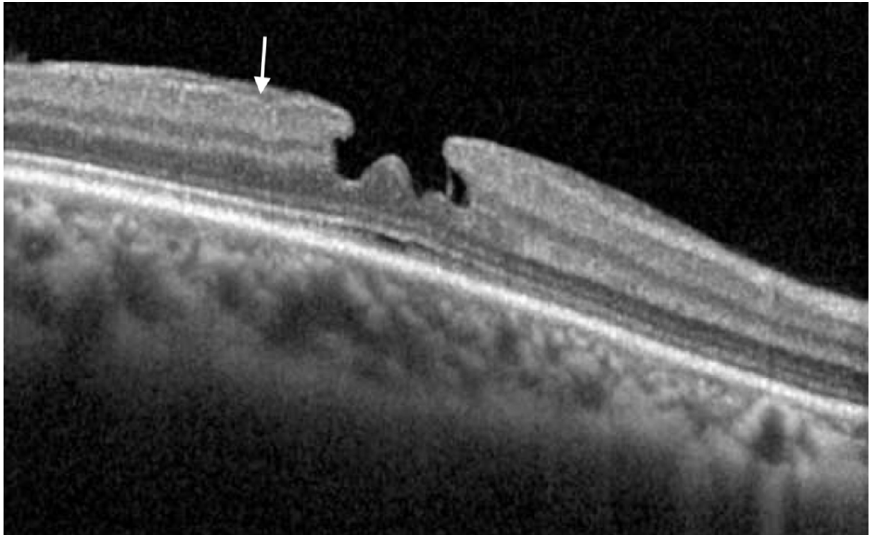
Figure 1. B scan SD-OCT of an eye with an LMH. Notice the epiretinal proliferation (arrow) that is isoreflective and conforms to the retinal surface without altering the retina shape. There is no evidence of traction. The foveal contour is irregular. SD-OCT: Spectral Domain optical coherence tomography; LMH: Lamellar Macular Hole.